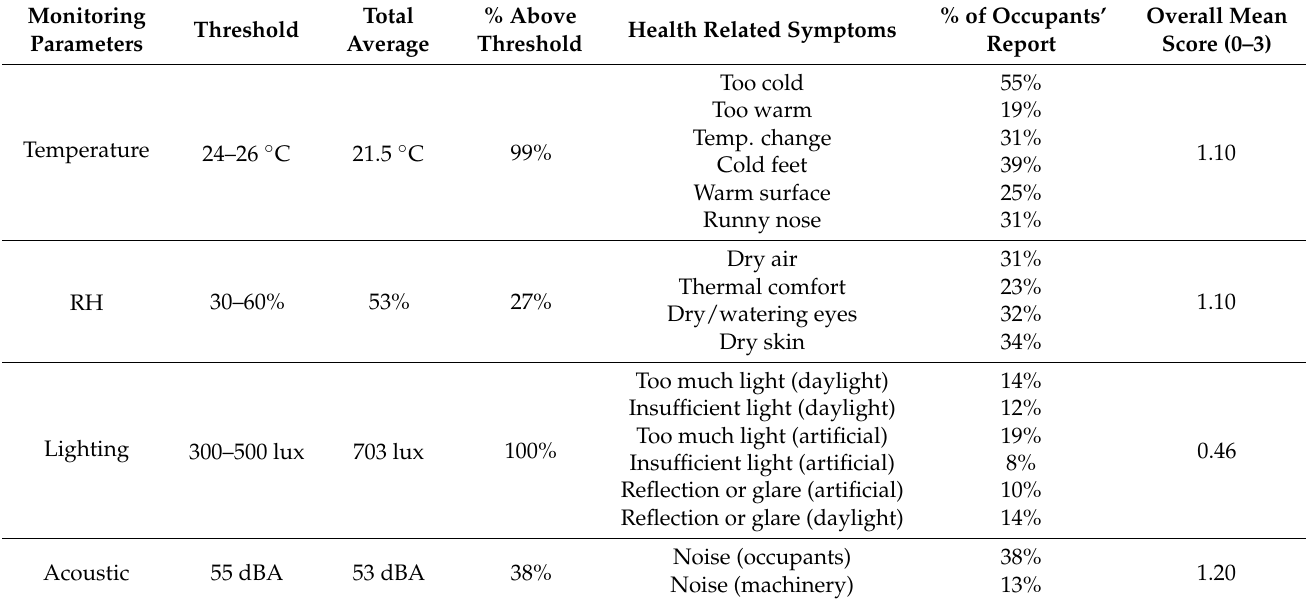
Table 4. Comparative summary of IEQ monitoring and surveying